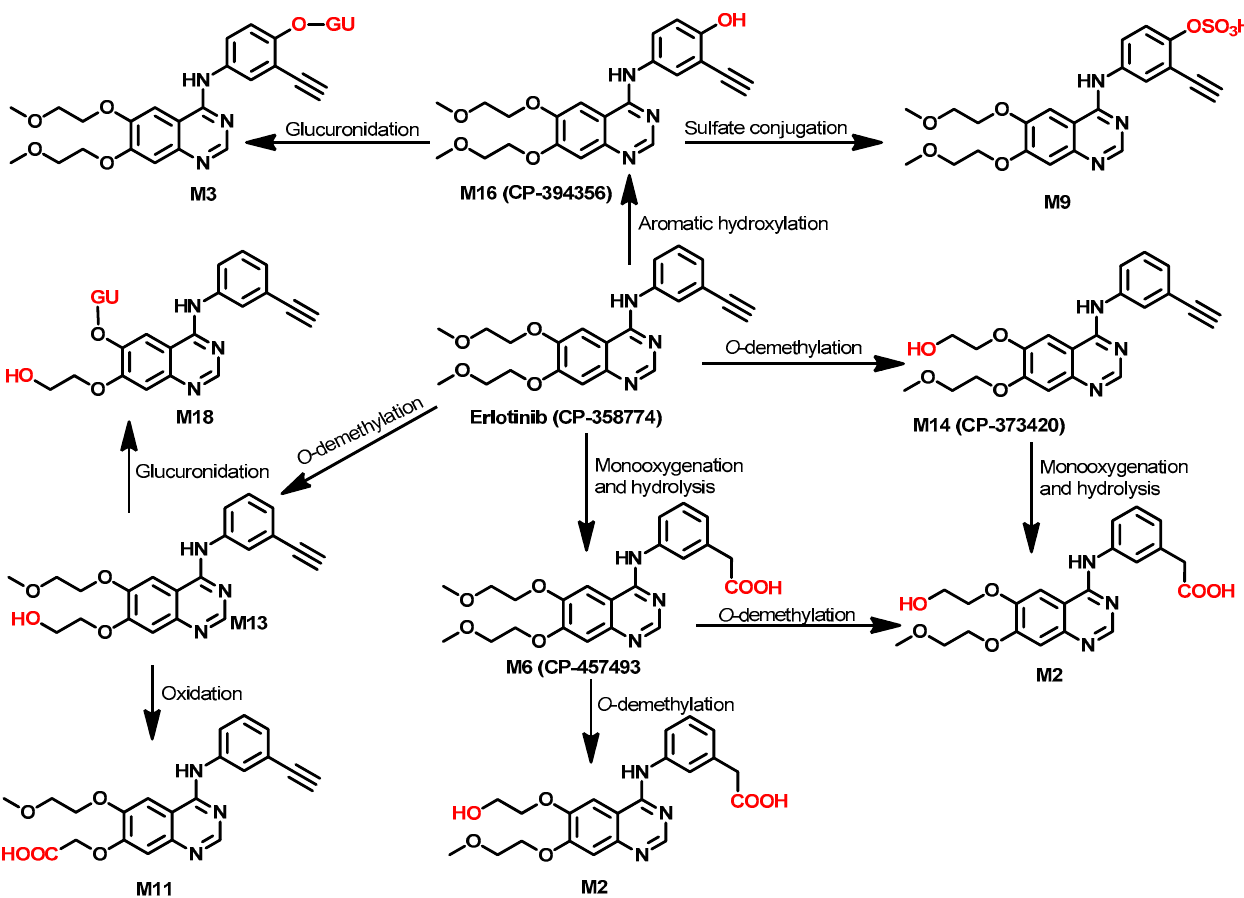
Figure 29. Proposed metabolic pathways of erlotinib in human.